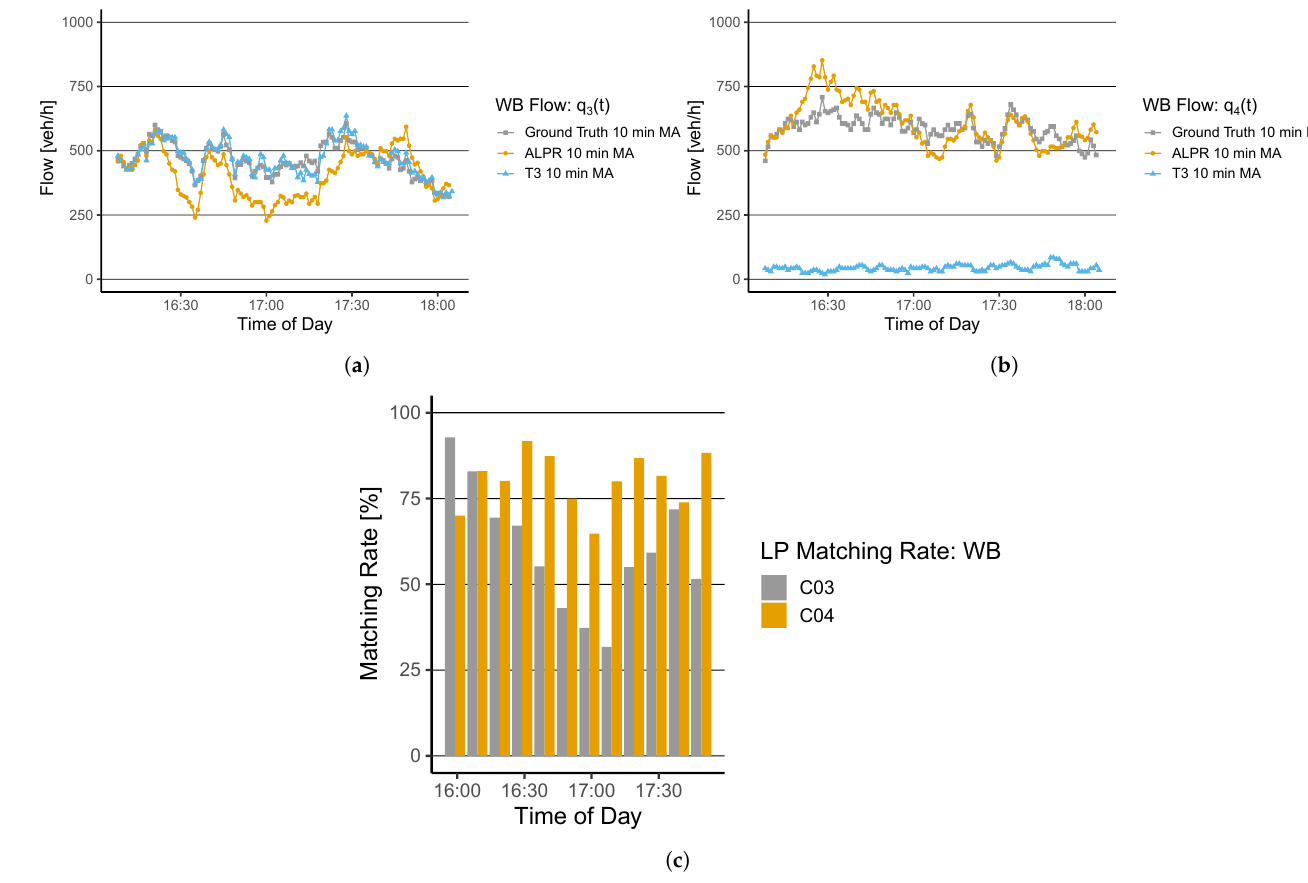
Figure 6. Flow evaluation ( a ) q 3 ( t ) and ( b ) q 4 ( t ) at EB from the ground-truth measurement, the ALPR, and the thermal camera T3; ( c ) shows the matching rate of the ALPR algorithm for both derived